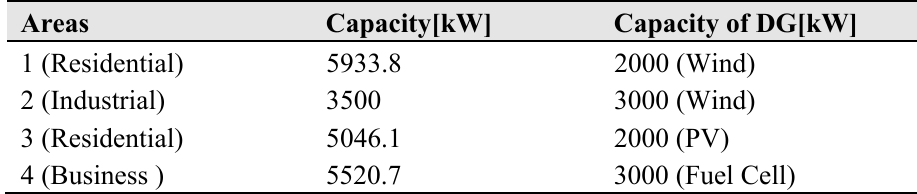
Table 2. Peak capacity of the area and capacity of DG [14].